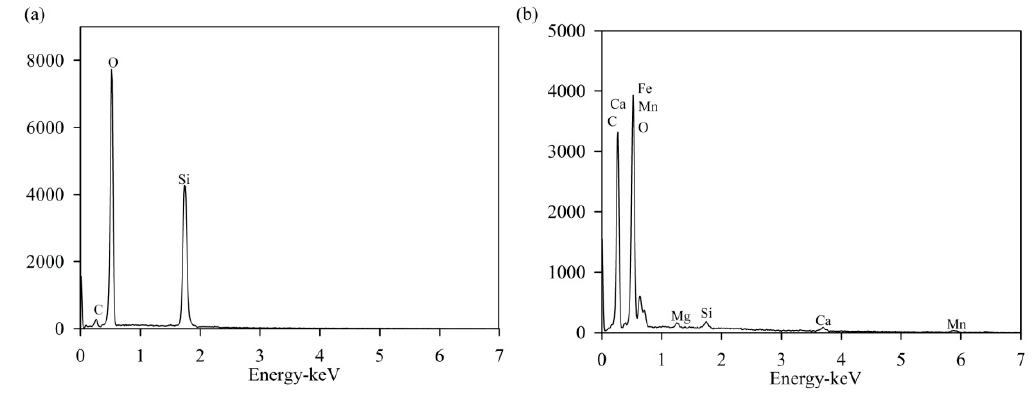
Figure 8. The EDS images of ( a ) normal quartz sand and ( b ) MeO x .